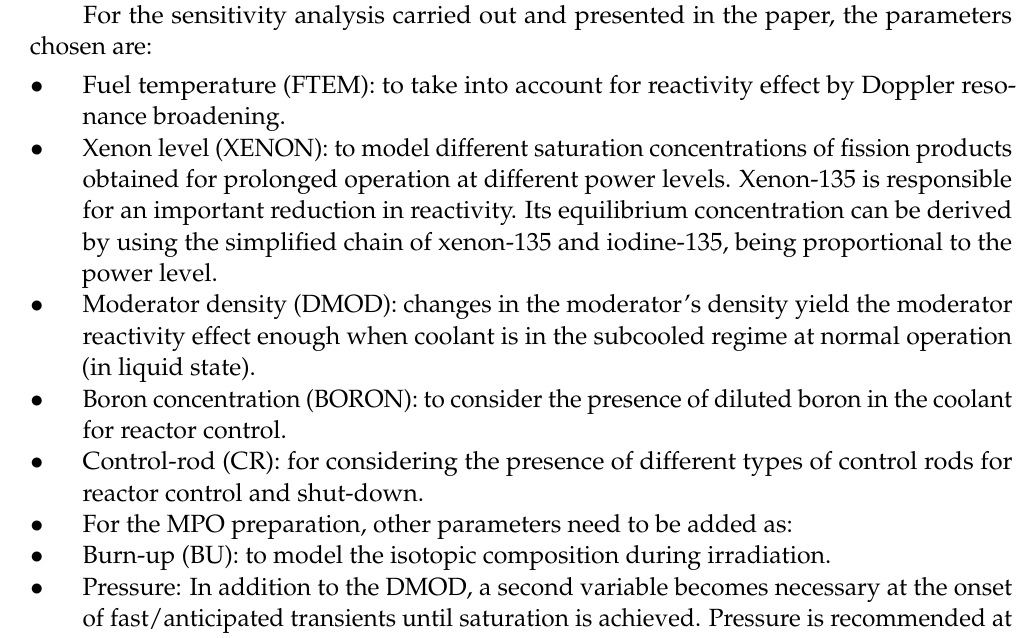
Figure 8. PWR Assembly cases. ( a ) UOX; ( b ) UGD.